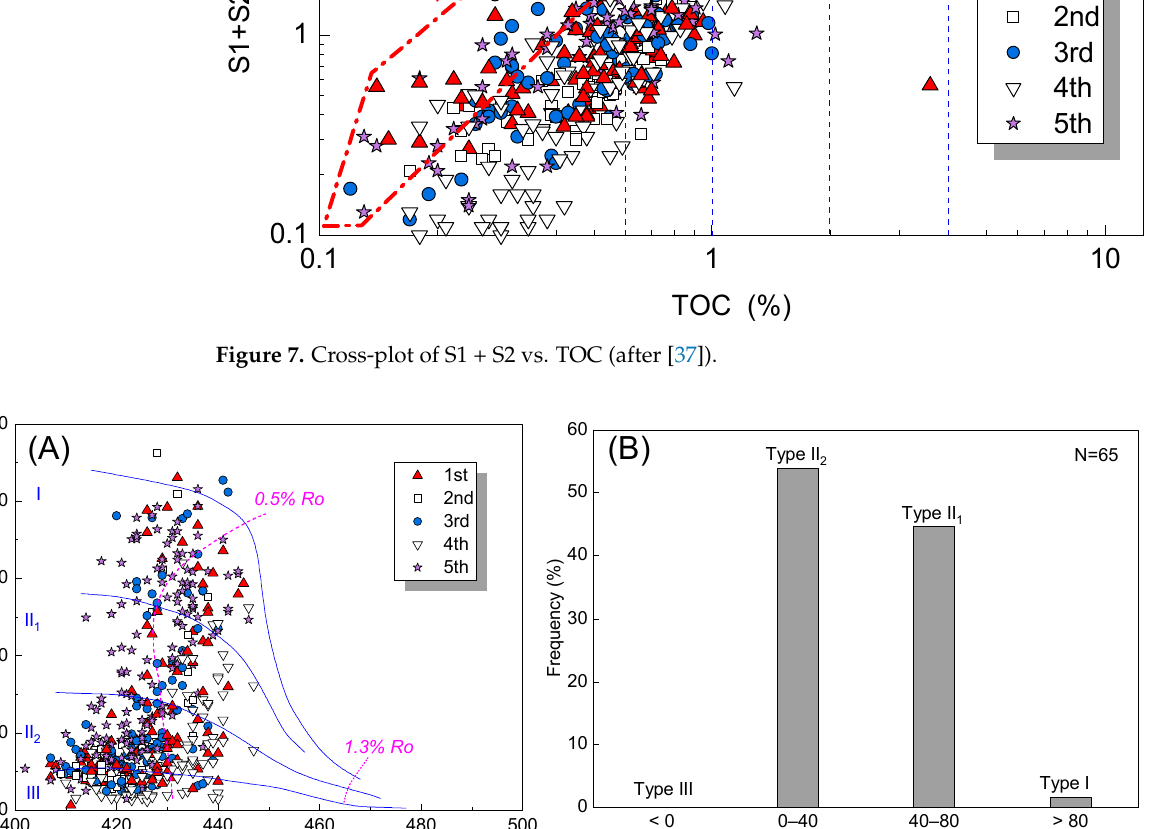
Figure 8. ( A ) Cross-plot of Tmax vs. HI (after [38]). ( B ) Frequency distribution of TI (type index), TI = 100 × (sapropelinite, %) + 50 × (liptinite, %) − 75 × (virtrinite, %) − 100 × (inertinite, %), and TI > 80, 80 > TI > 40, 40 > TI > 0, and TI < 0 indicate Type I, Type II 1 , Type II 2 , and Type III, respectively.